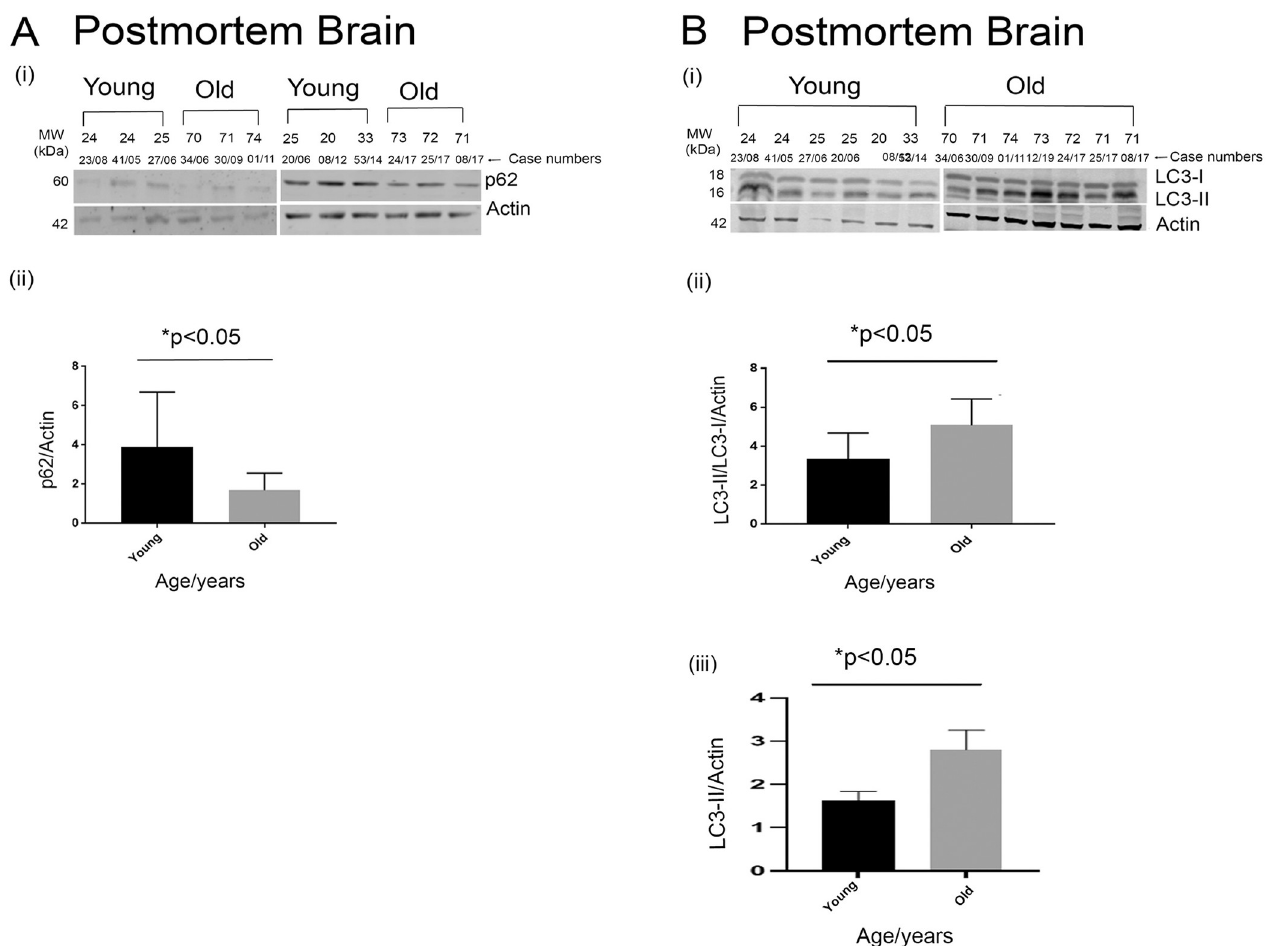
Fig 3. Autophagy is significantly increased in the healthy older brains compared to the younger brains in post-mortem tissues. Representative western blot images for p62 and Actin in post-mortem brains (A i) and quantification of p62 normalized to Actin (A ii). Representative western blot images for LC3 and Actin in post-mortem brains (B i) and quantification of LC3-II/LC3-I normalized to Actin (B ii) and LC3-II normalised to Actin (B iii). In post-mortem samples n = 7 (older brains), n = 6 (younger brains). � p < 0.05, by two-tailed unpaired t test. Data represent mean ± SEM (A ii and B